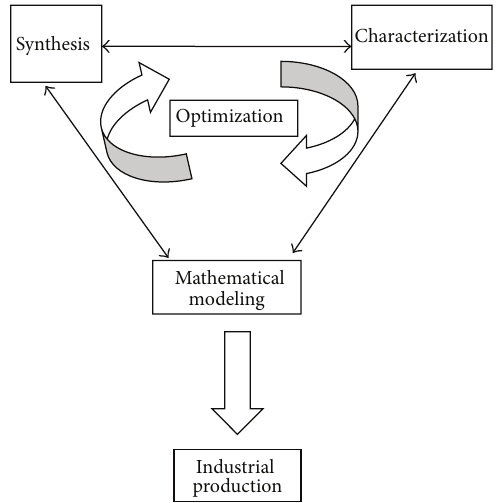
Figure 1: Various stages in the commercialization of new products and